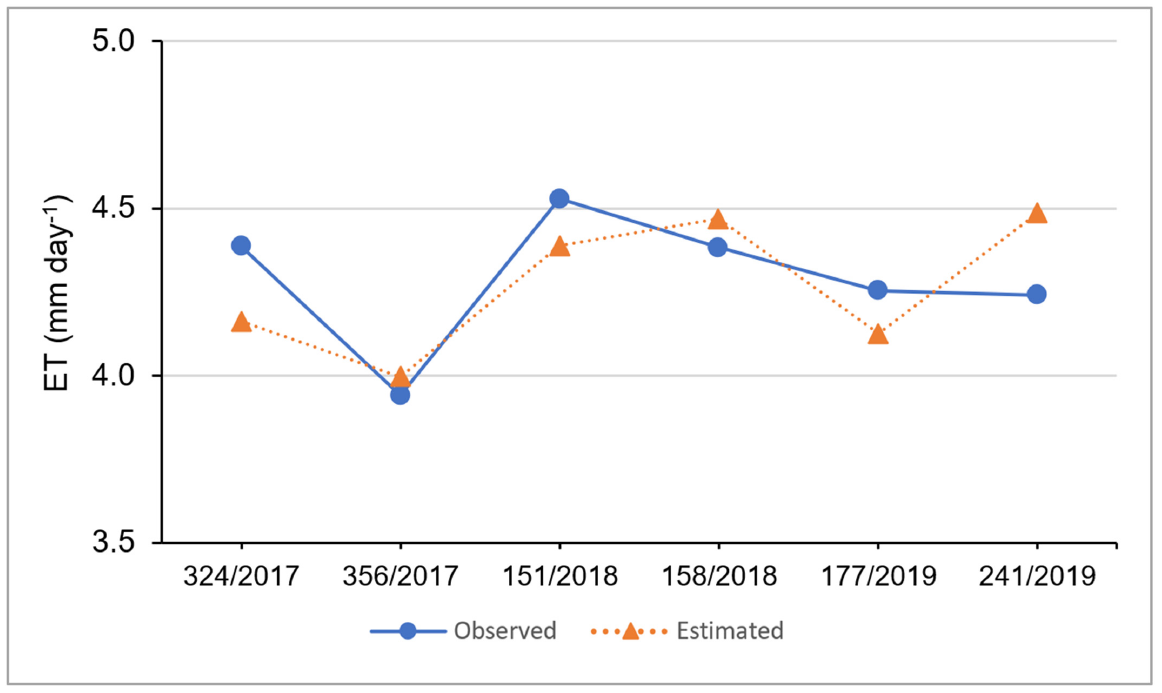
Figure 4. Evapotranspiration values of the micrometeorological tower data and the data estimated by SEBAL .